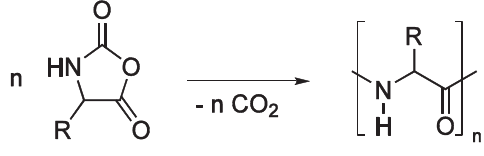
Figure 46. Formation of “ Nylon-2 ” from a Leuchs’